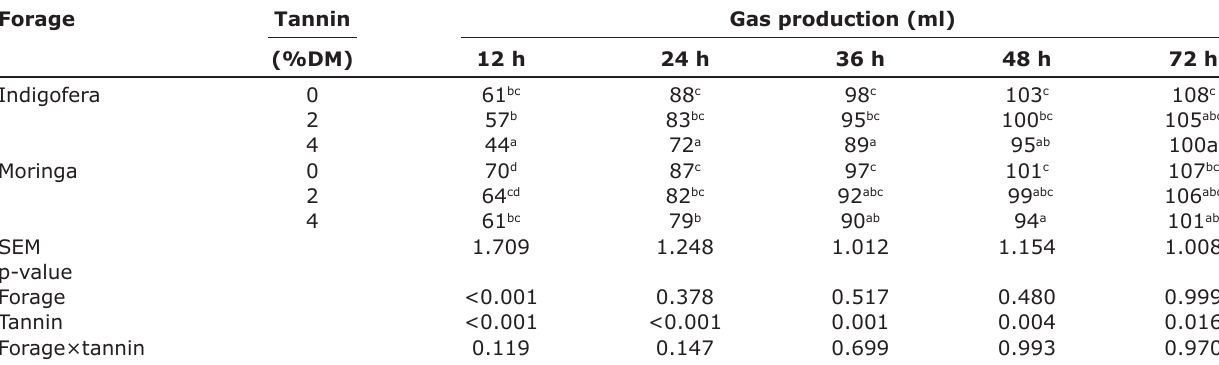
Table-3: In vitro gas production at a various incubation period of Indigofera and Moringa leaf silage with different level of chestnut tannin addition. Forage